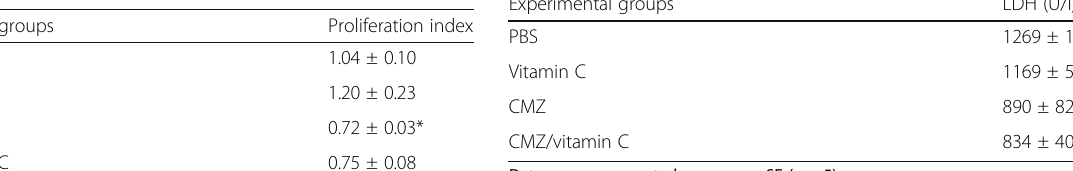
Table 8 Changes in the level of LDH of male Swiss albino